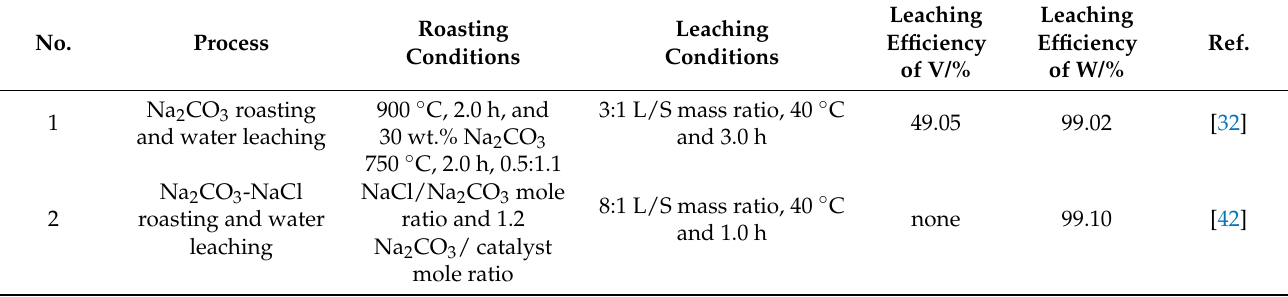
Table 6. The leaching efficiencies of V and W for different